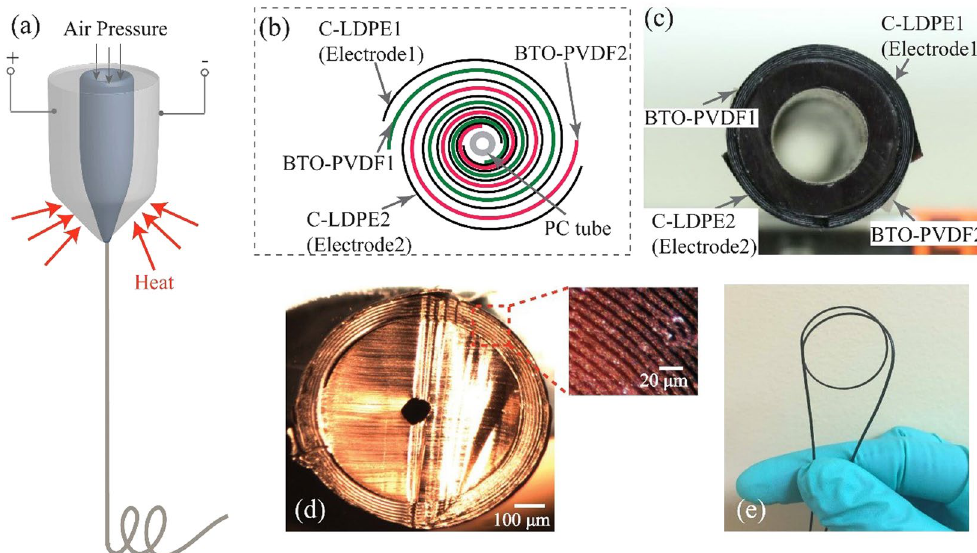
Figure 1. Fabrication of the piezoelectric microstructured fibers via drawing of the multimaterial preforms. ( a ) Schematic of the fabrication process of a piezoelectric fiber. ( b ) Schematic of the multilayer structure in the fiber preform and in the microstructured fiber. ( c ) Photo of a preform cross section. ( d ) Photo of a cross section of the piezoelectric microstructured fiber. Insert: the magnified view of a multilayer structure. ( e ) Photo of a piezoelectric microstructured